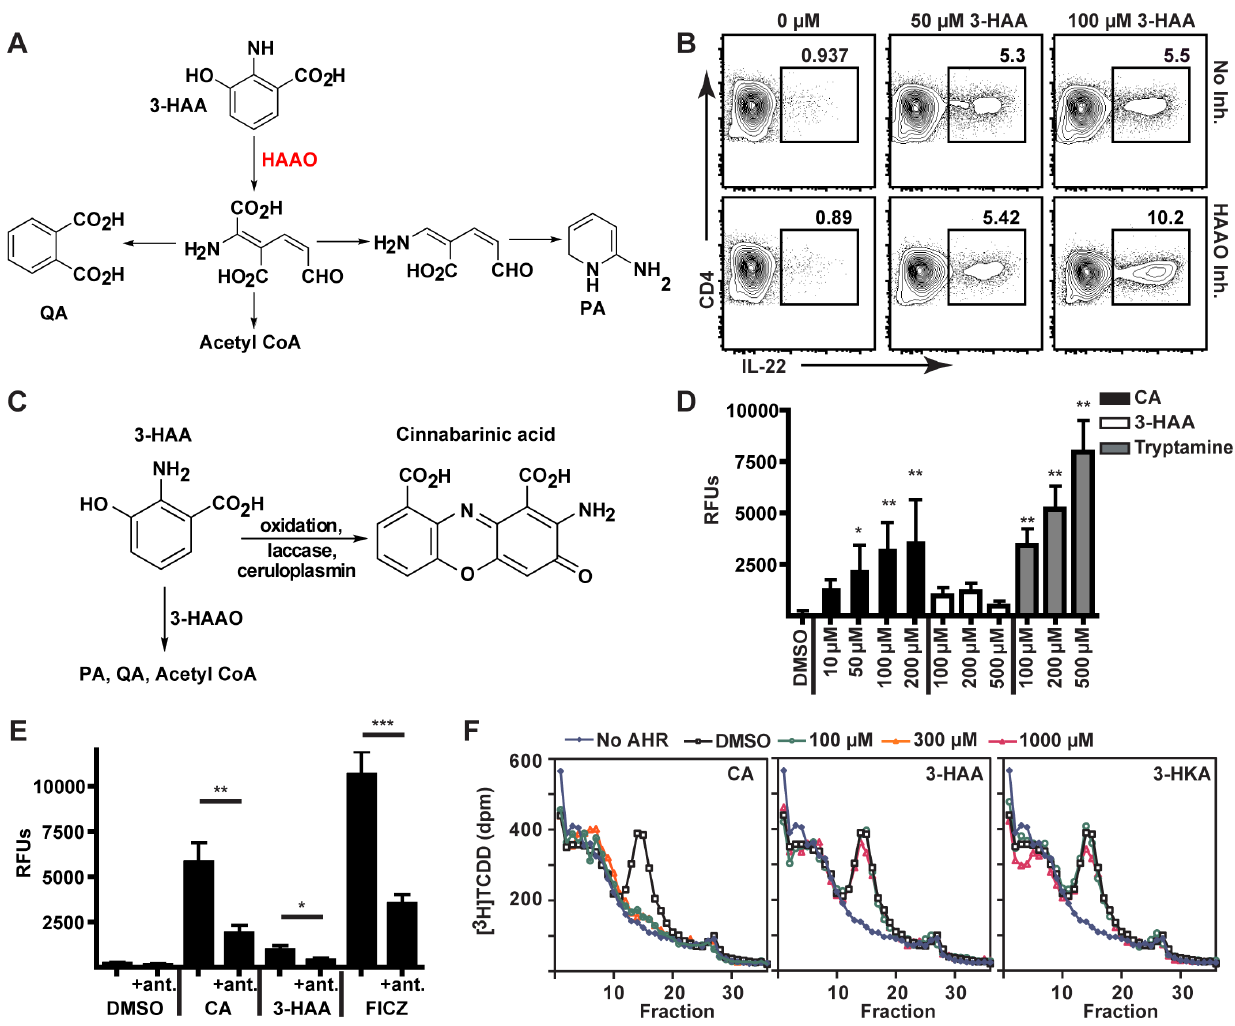
Figure 4. CA is an endogenous AHR agonist generated by oxidative dimerization of 3-HAA. (A) Metabolic pathways downstream of 3- HAA catalyzed by the enzyme, 3-hydroxyanthranilate 3,4-dioxygenase (HAAO), including intermediates upstream of PA and QA. (B) Flow cytometric analysis of CD4 + T cells in human PBMCs stimulated in the presence of varying concentrations of 3-HAA (50 m M or 100 m M) with or without the HAAO inhibitor, 4-F-3-HAA (50 m M). Data are representative of three experiments. (C) An alternative pathway of 3-HAA metabolism can generate CA either by non-enzymatic (oxidation) or enzymatic (such as laccase or ceruloplasmin) processes. (D) Fluorescence [measured in relative fluorescence units (RFUs)] of the AHR-responsive reporter construct in cells incubated with varying concentrations of 3-HAA or CA. Tryptamine was a positive control. *, p , 0.05 (ANOVA, Scheffe’s). Error bars represent SD. (E) Fluorescence of an AHR-responsive reporter construct measured following incubation of H1G1.1c3 cells with DMSO control, CA (200 m M), 3-HAA (200 m M), or the positive control FICZ (100 nM), with or without the AHR antagonist CH- 223191 (50 m M). *, p , 0.01. **, p , 0.001. ***, p , 0.0001. (2-way ANOVA, Bonferroni’s post-test). Error bars are SD. (F) [ 3 H]TCDD displacement from in vitro translated human AHR protein by incubation with varying concentrations of CA, 3-HAA, or 3-HKA. Data are representative of four (CA and